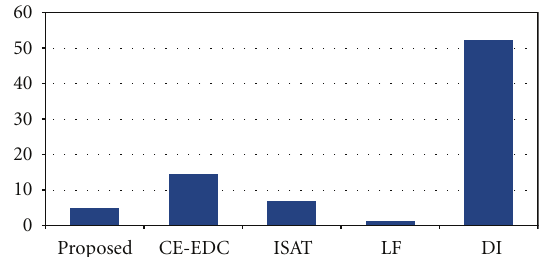
Figure 23: Comparison of computation times for flow solver per iteration.